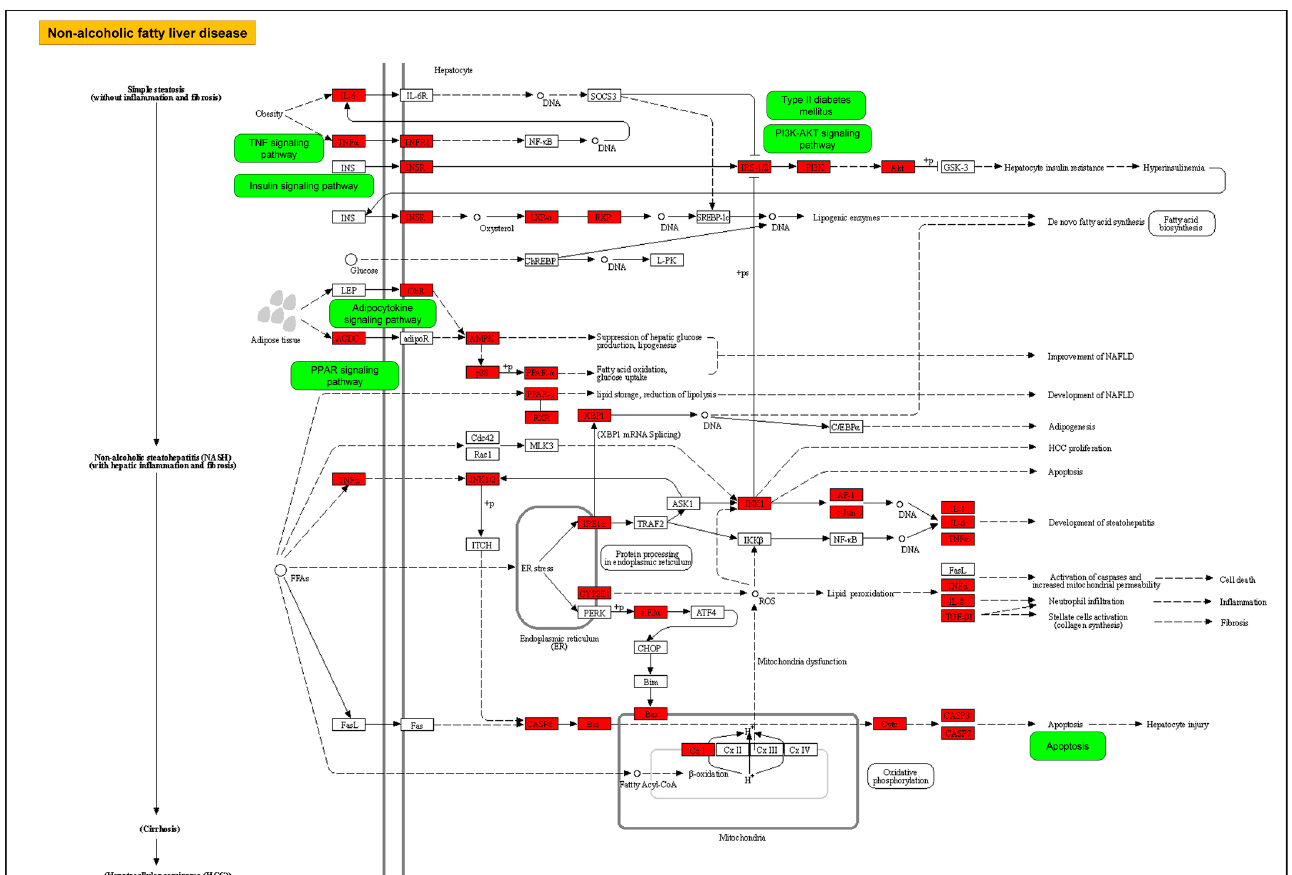
Figure 8. Pathway map of the mechanisms of Aloe vera against NASH. This figure was adapted from the reference pathway of NAFLD from the KEGG database (https://www.kegg.jp/pathway/map04932/, accessed on 2 September 2022). Target genes (red) and pathways (green) of Aloe vera for NASH treatment were obtained from a target fishing process and KEGG enrichment analysis, respectively. DNA, deoxyribonucleic acid; NASH, non-alcoholic steatohepatitis; NAFLD, non- alcoholic fatty liver disease; TNF, tumor necrosis factor.